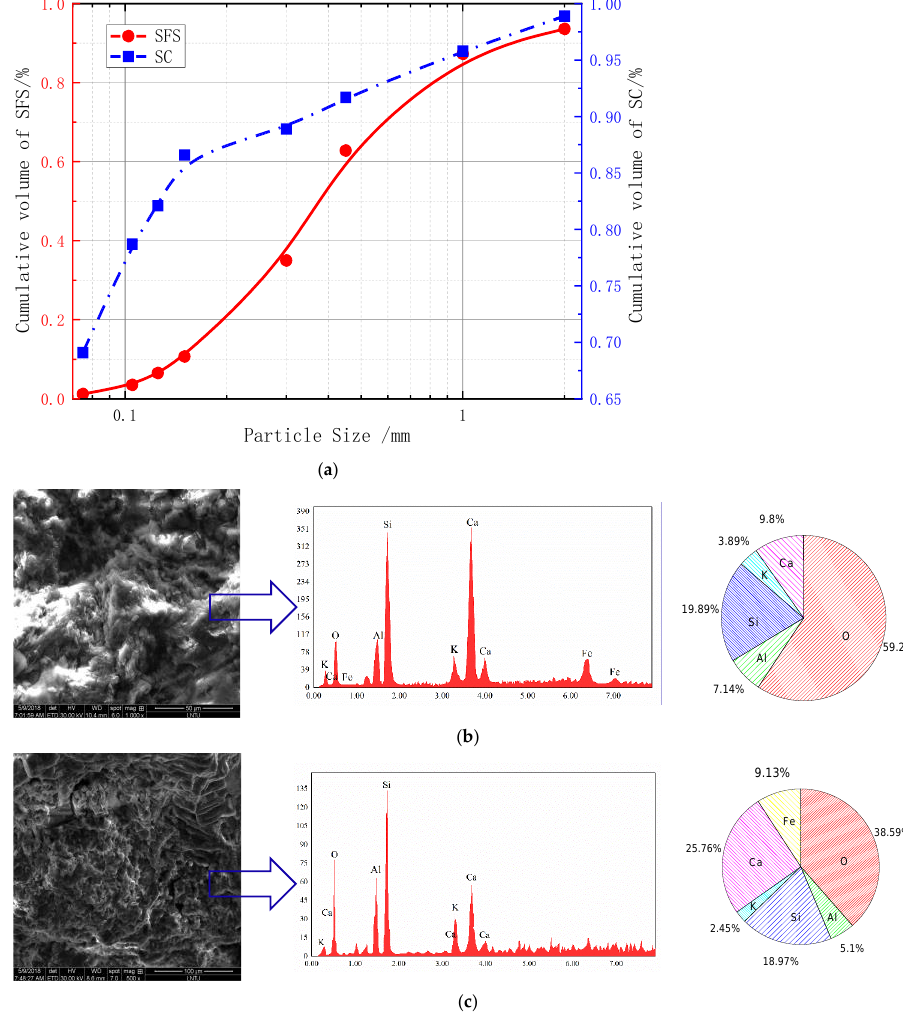
Figure 3. Particle size distribution and chemical components. ( a ) Particle size distribution. ( b ) Microscopic morphology and chemical composition of SFS. ( c ) Microscopic morphology and chemical composition of SC.